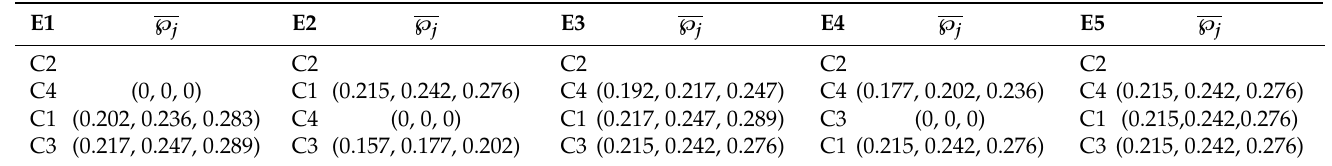
Table 3. Evaluation of criteria after transformation of Z numbers into TFNs.